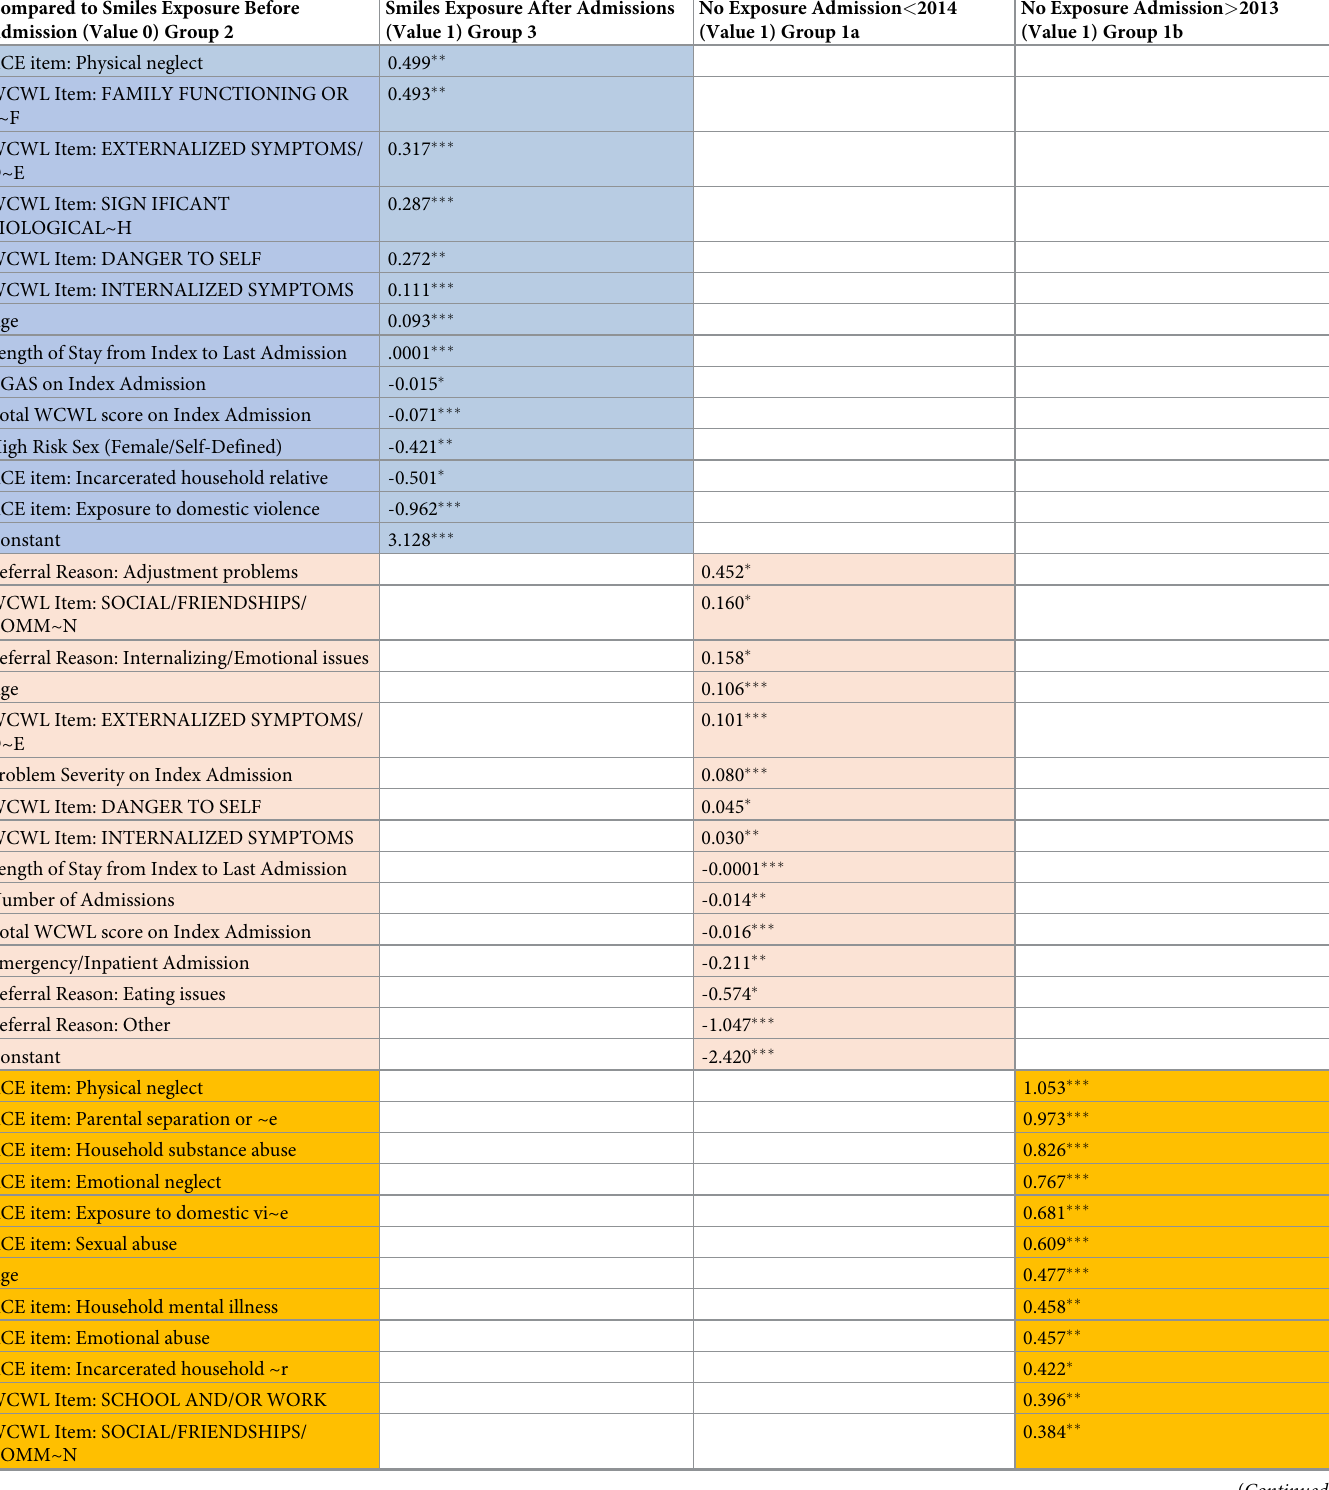
Table 2. Estimates comparing admissions after smiles exposure to all other groups in three logistic